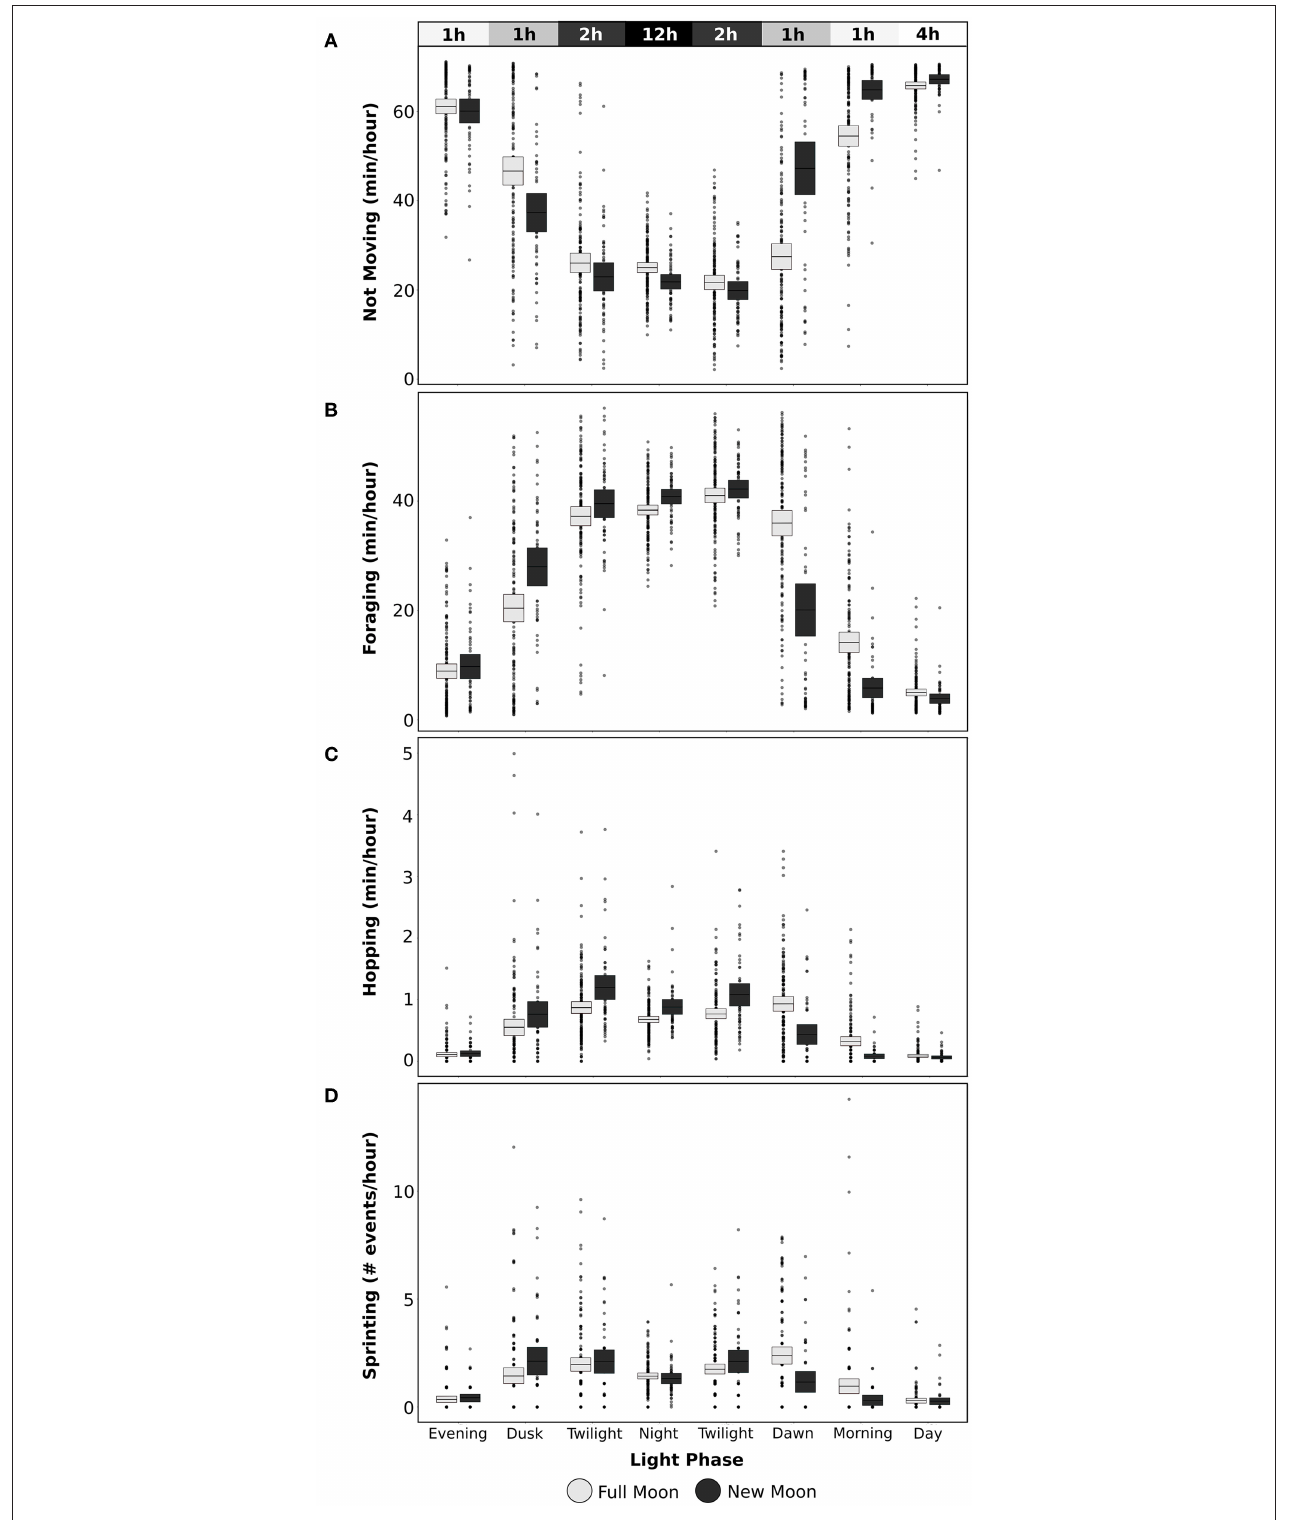
FIGURE 7 | Average time spent by snowshoe hares on each behavior during different light phases of a day and moon phase with light boxes for full moon (lunar illumination > 0.66) and dark boxes for new moon (lunar illumination < 0.33) conditions (mean ± 95% CI). Not moving (A) , foraging (B) , and hopping (C) are presented as time spent (min/h) expressing each behavior, while sprinting (D) is depicted as number of events per hour. Bar at top indicates the solar illumination level of each light phase and average number of hours that occur during that phase in a 24-h period.